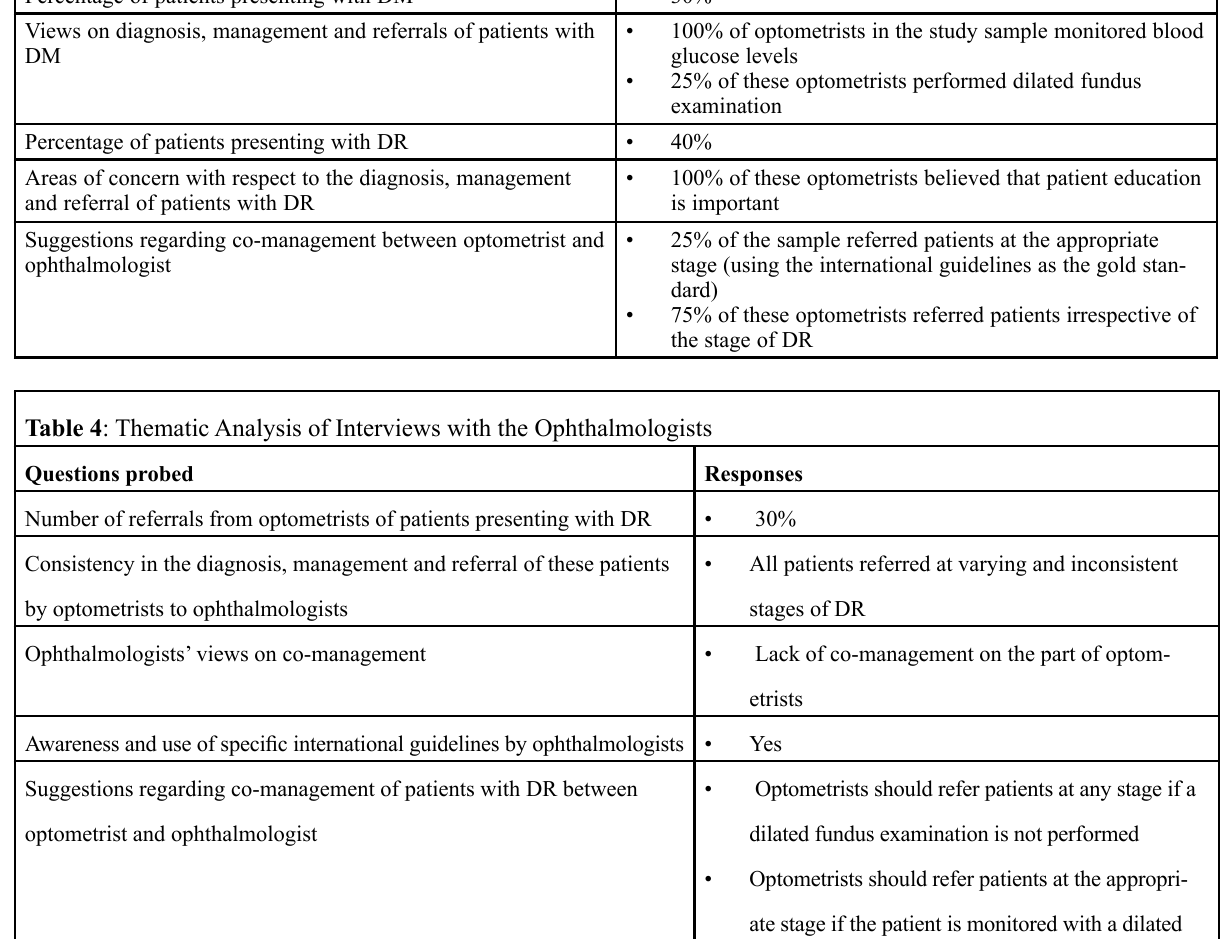
Table 3 : Thematic Analysis of Interviews with the Optometrists Emergent themes